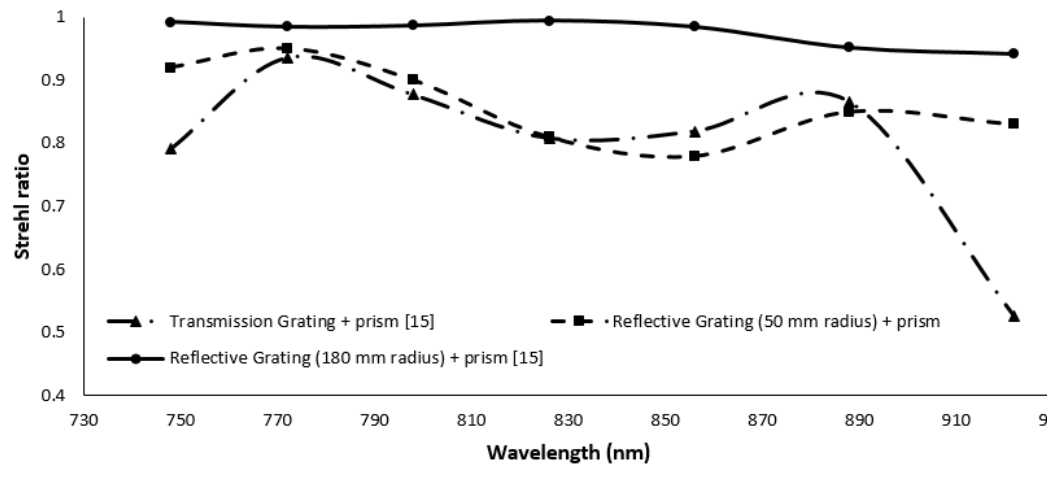
Figure 6. Strehl ratio of the proposed spectrometer and previous works